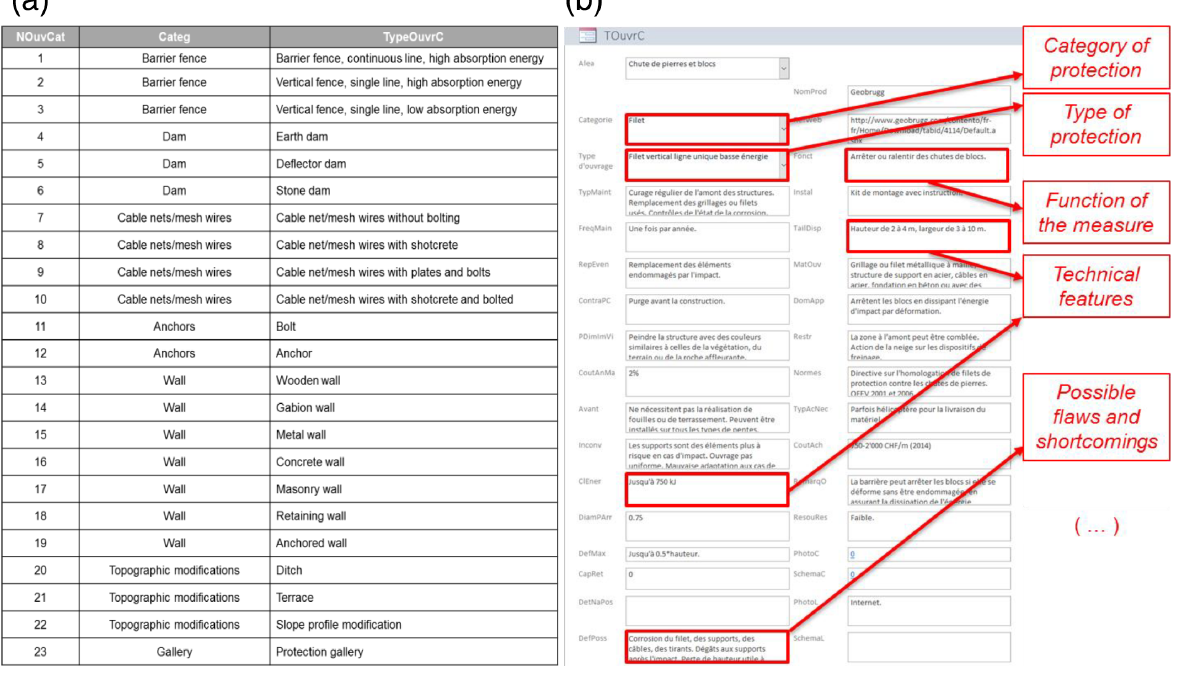
Figure 3. Database for rockfall protection measures. (a) Types and categories of rockfall protections included in the database. (b) Example of a form implemented in Access for each protection (here referred to a vertical barrier fence installed in single line, with low energy retention